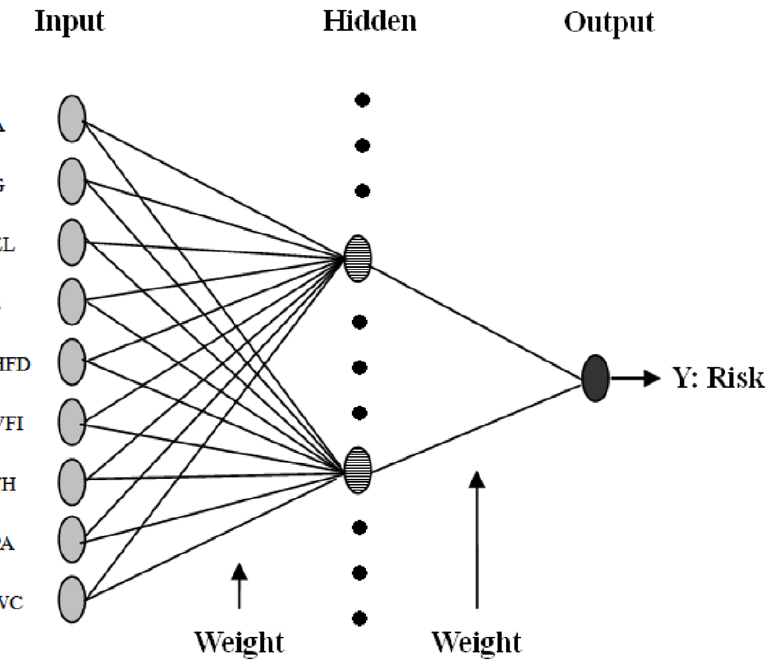
Figure 1. Framework of artificial neural network model for predicting an individual’s risk of dyslipidemia. The input layer contained 9 neurons. In the hidden layers, the numbers of neuron were 21. The output layer had only one neuron representing the probability of dyslipidemia. Abbreviations: X A , age; X G , gender; X EL , educational level; X S , smoking; X HFD , high-fat diet; X VFI , vegetable and fruit intake; X FH , family history of dyslipidemia; X PA , physical activity; X WC , waist circumference.